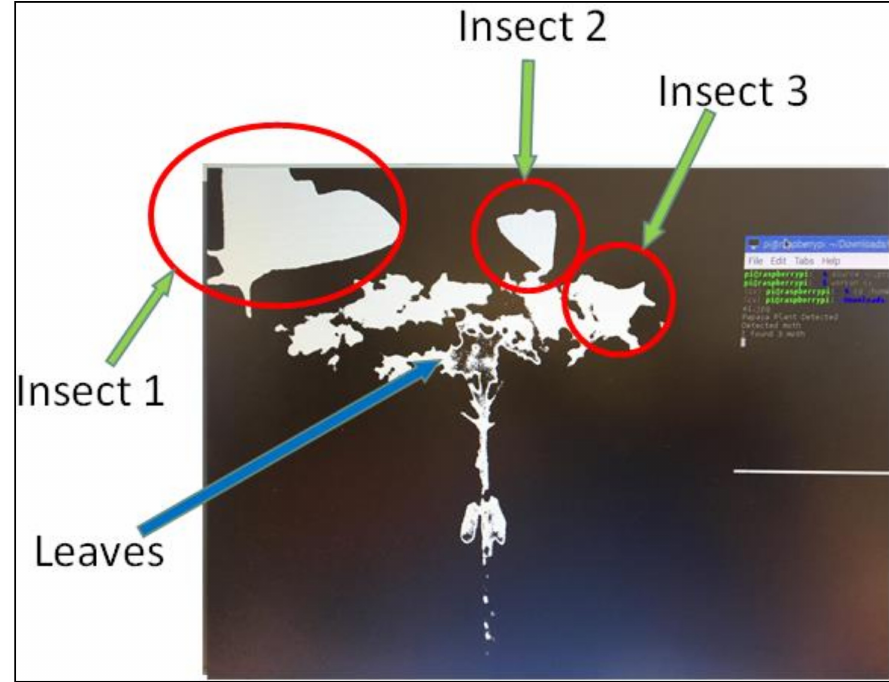
Figure 12. Pest detection while operating the MpSFR in the Papaya test field.